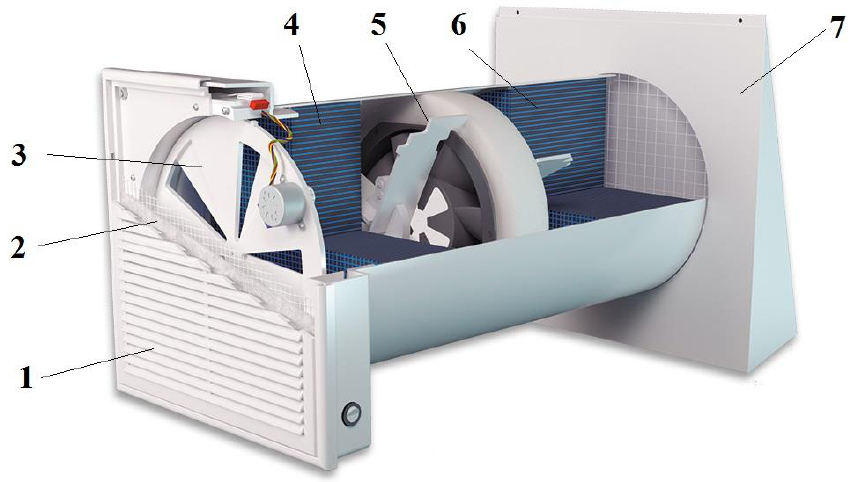
Figure 4. UVRC-50 device (ventilation compact recuperator with a maximum capacity of 50 m 3 /h) produced by SPF “Ecotherm”: 1: decorative grill; 2: G2-G3 filter; 3: automatic valve; 4: small regenerator; 5: reversible fan; 6: large regenerator; 7: outer hood.